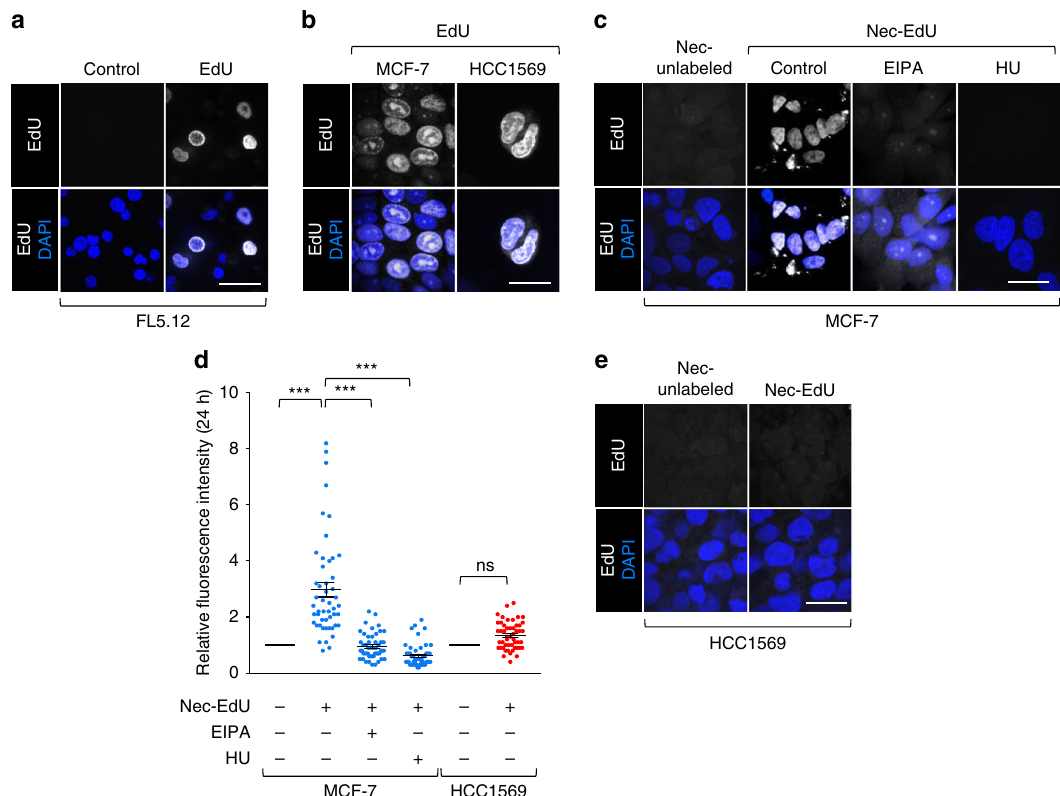
Fig. 4 Necrocytosis provides nucleotides. a FL5.12 cells labeled with EdU in complete medium; EdU detected with biotin-azide and streptavidin-Alexa488. b MCF-7 and HCC1569 cells labeled with free EdU as in a . c Macropinocytic MCF-7 cells ± EIPA (50 μ M) or hydroxyurea (HU, 10 mM) were supplemented with unlabeled or EdU-labeled necrotic cell debris (nec-EdU). d Integrated fl uorescence intensity per cell in c , e normalized to cells fed unlabeled necrotic cell debris. A total of 50 cells were quanti fi ed from three independent experiments except for hydroxyurea treatment where n = 2; mean ± SEM shown. Using a one-way ANOVA and Tukey ’ s correction (MCF-7) or an unpaired, two-tailed t -test (HCC1569), *** P ≤ 0.001; ns, not signi fi cant, P > 0.05. e As in c but for non-macropinocytic HCC1569 cells. Scale bars, 20 µ